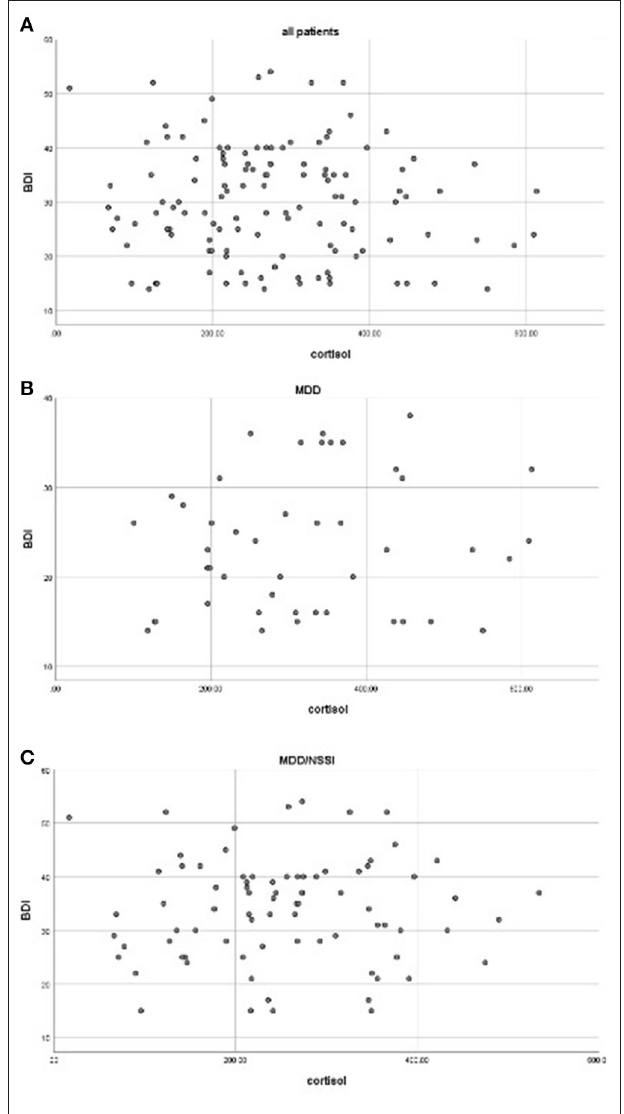
FIGURE 1 | Correlations between cortisol levels and BDI scores in all patients (A) , MDD (B) , and MDD/NSSI patients (C) (all p >